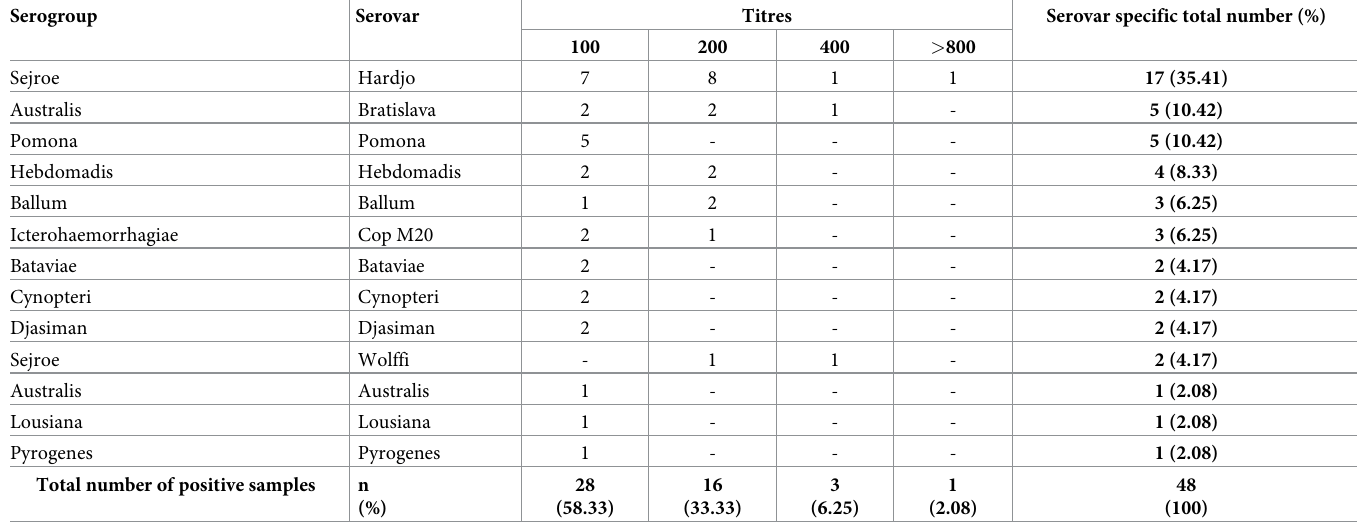
Table 1. Distribution of infective serovars and maximum titres identified by MAT in serum samples from 194 ovine animals slaughtered at slaughterhouse. Serogroup